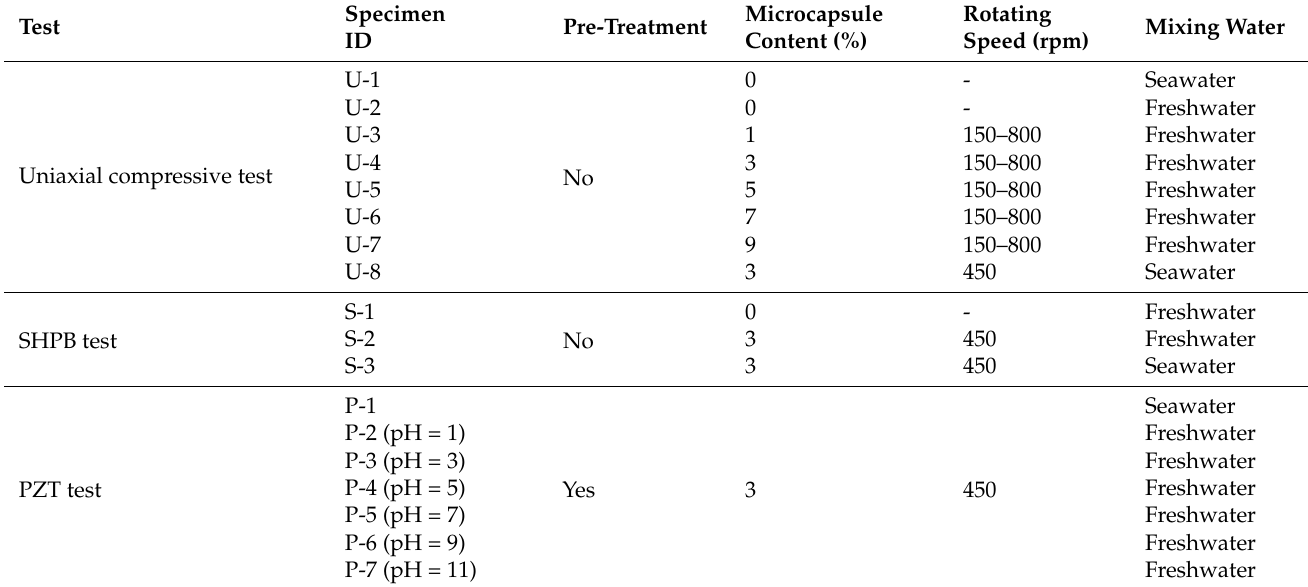
Table 4. Specimen preparation